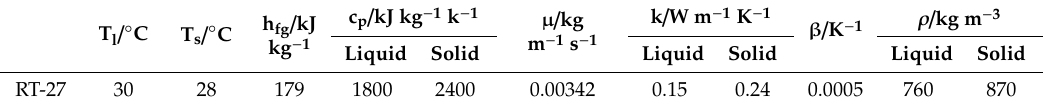
Figure 1. PCM filled heat sink (𝑊 × 𝐻) equipped with two horizontal fins (𝐿 (cid:3033) × 𝐻 (cid:3029) ) . Table 1. PCM properties [12].